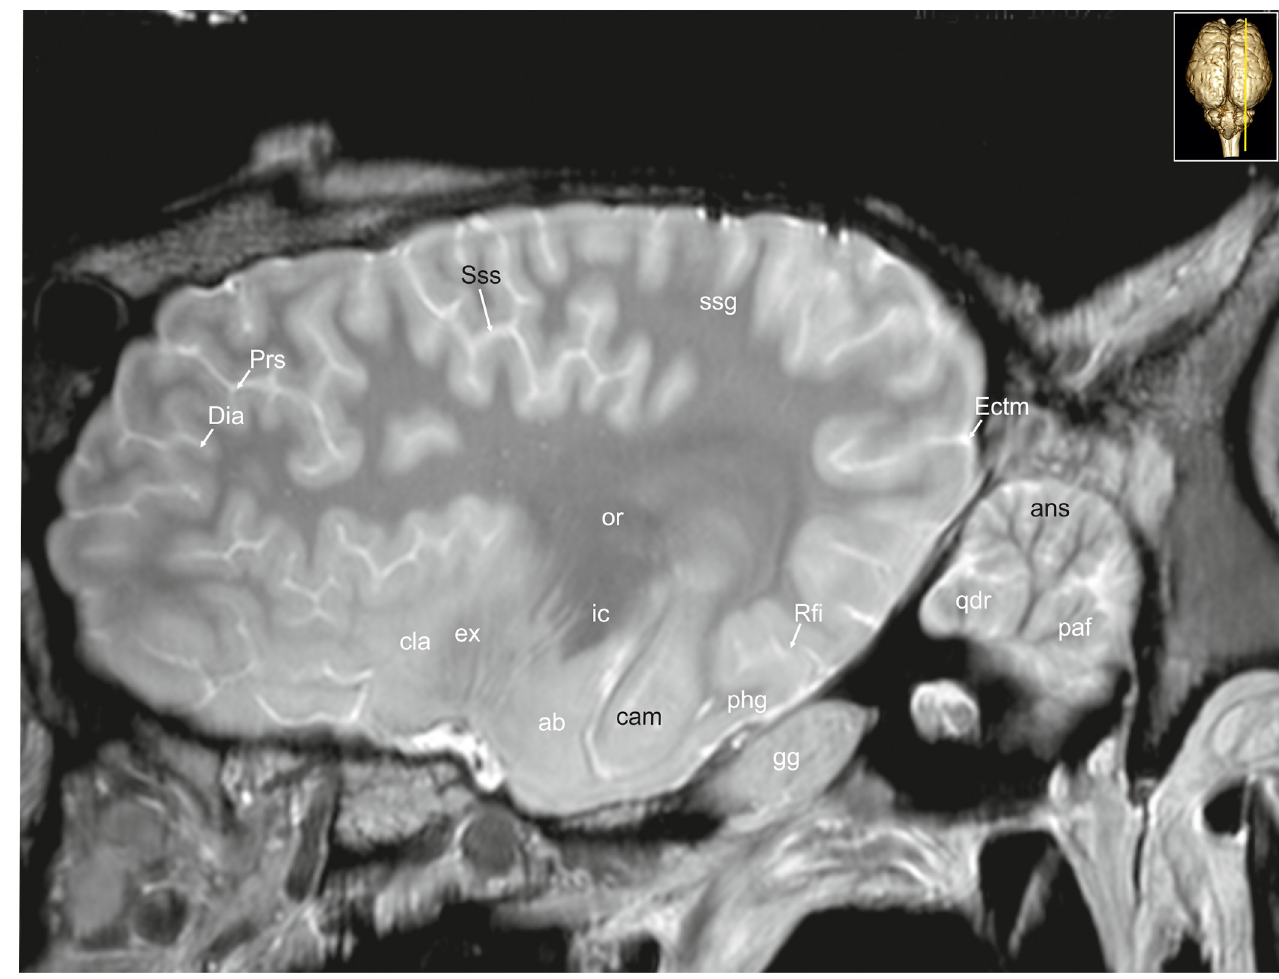
Fig 33. Parasagittal magnetic resonance image of the equine brain at the level of the amygdaloid body. ab: amygdaloid body, ans: ansiform lobule, cam: ammon’s horn, cla: claustrum, Dia: diagonal sulcus, Ectm: ectomarginal sulcus, ex: extreme capsule, gg: Gasserian ganglion, ic: internal capsule, or: optic radiation, paf: paraflocculus, phg: parahippocampal gyrus, Prs: presylvian sulcus, qdr: quadrangulare lobule, Rfi: rhinal fissure, ssg: suprasylvian gyrus, Sss: suprasylvian sulcus.